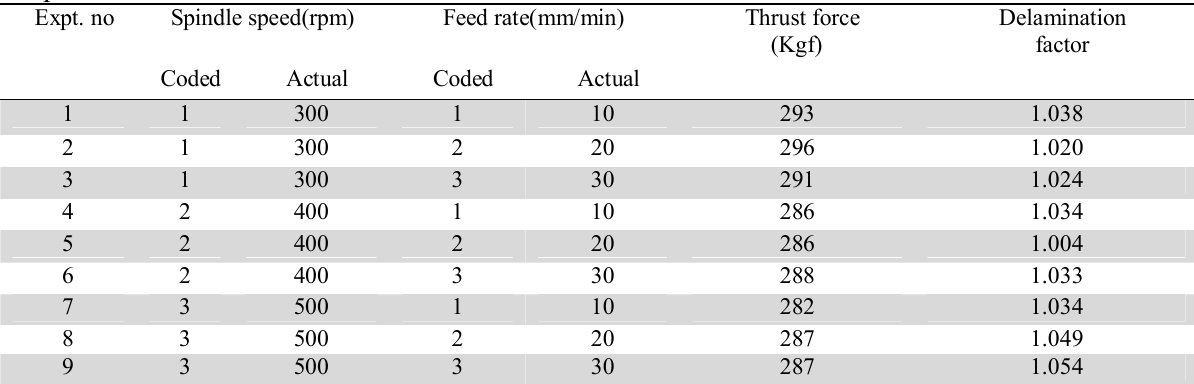
Experimental values of F